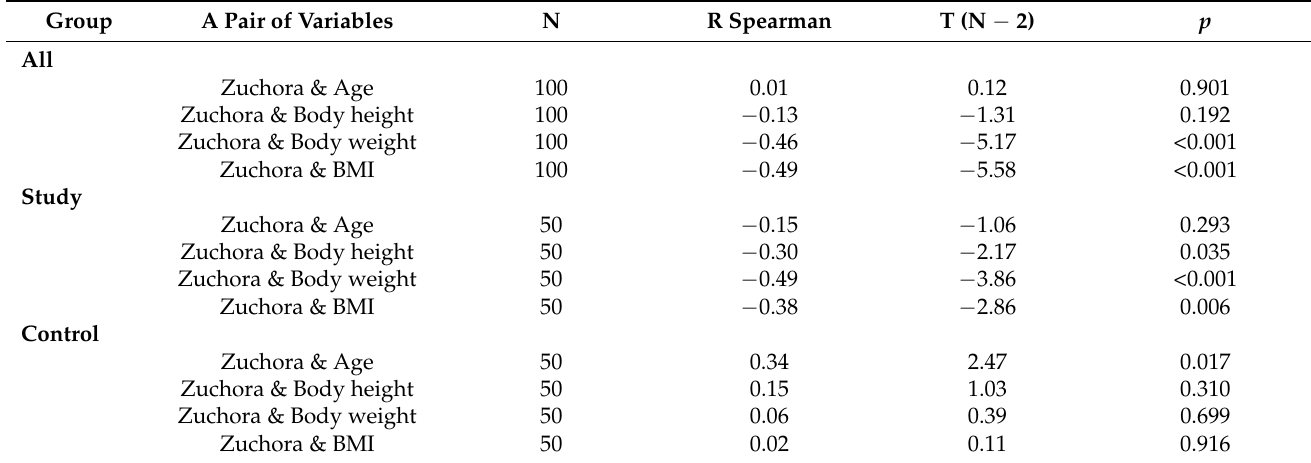
Table 8. Correlations of the results in the Zuchora test with the parameters of